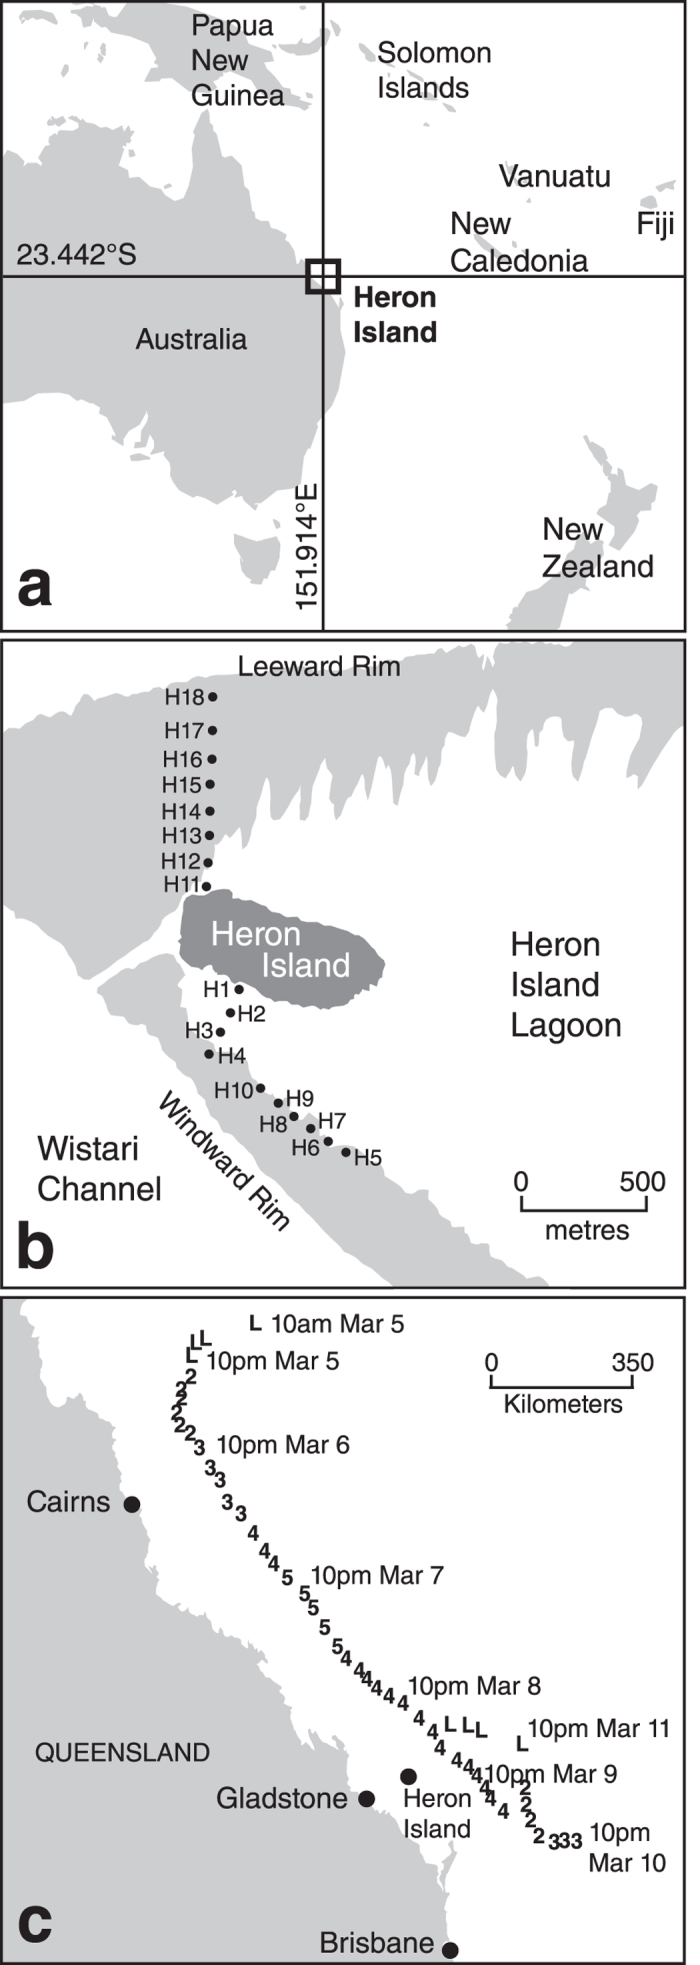
Map of Heron Island and path of Cyclone Hamish.(a) Location of Heron Island. (b) Heron Island and Heron Reef flat, showing location of sample sites. (c) Path of Cyclone Hamish from formation to dissipation. Times and dates indicate location of Hamish at that instance. Numbers indicate both path of Hamish’s ‘eye’ and its intensity at that point in time (intensity values based upon Australian tropical cyclone intensity scale). (a,c) Generated in R.3.1.167 using the ‘maps’ package (version 3.1.0)68. (b) Created with Adobe Illustrator CS3. Data for (c) comes from Joint Typhoon Warning Center operational warnings and advisories.